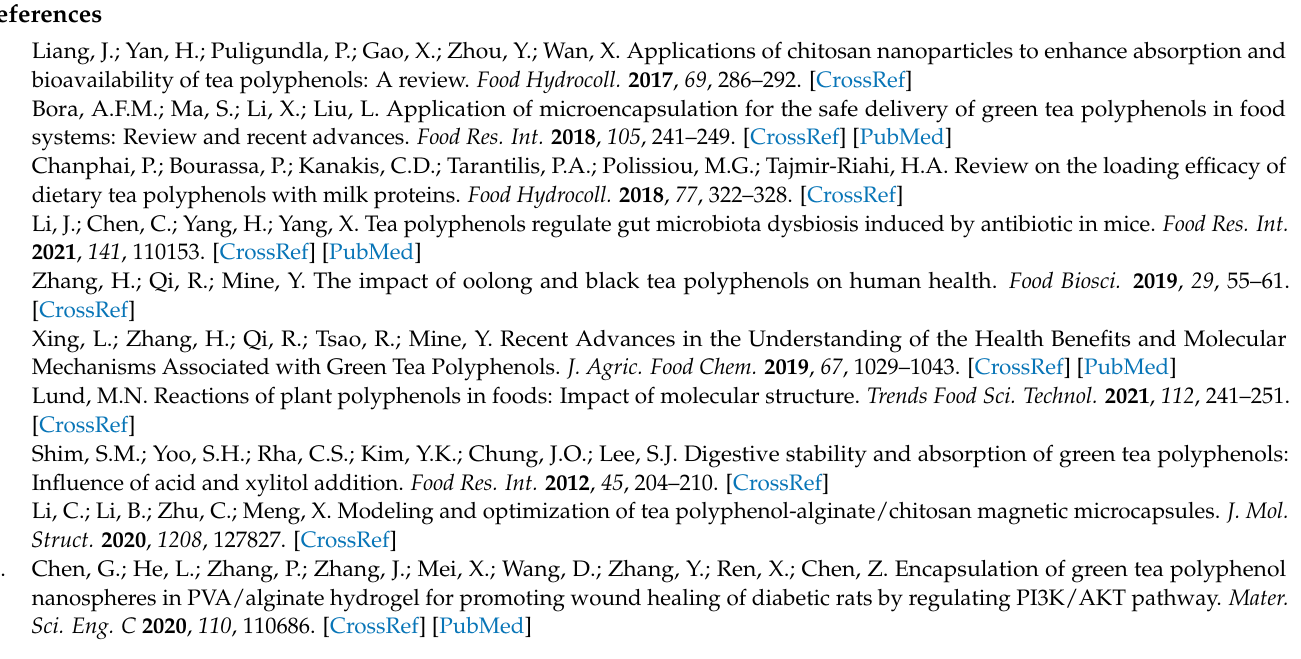
Table S4: The impact of Span80 concentration on particle size, loading rate and encapsulation rate, Table S5: The impact of n-butanol concentration on particle size, loading rate and encapsulation